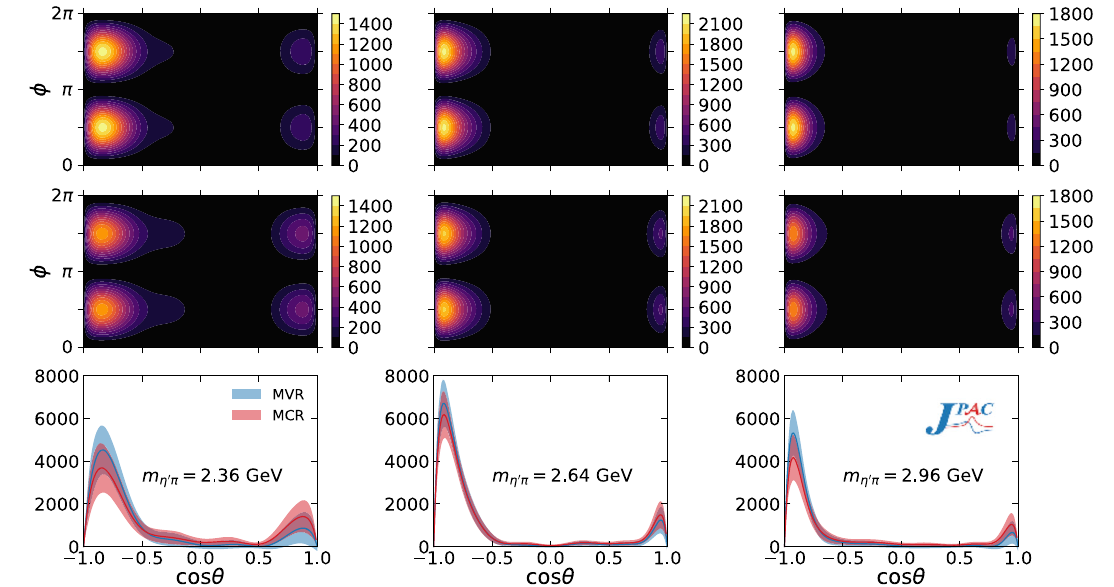
Fig. 2 Same as Fig. 1 for η (cid:2) π . We note that the η (cid:2) π backward peak is broader than the ηπ one and that the forward–backward asymmetry is more pronounced